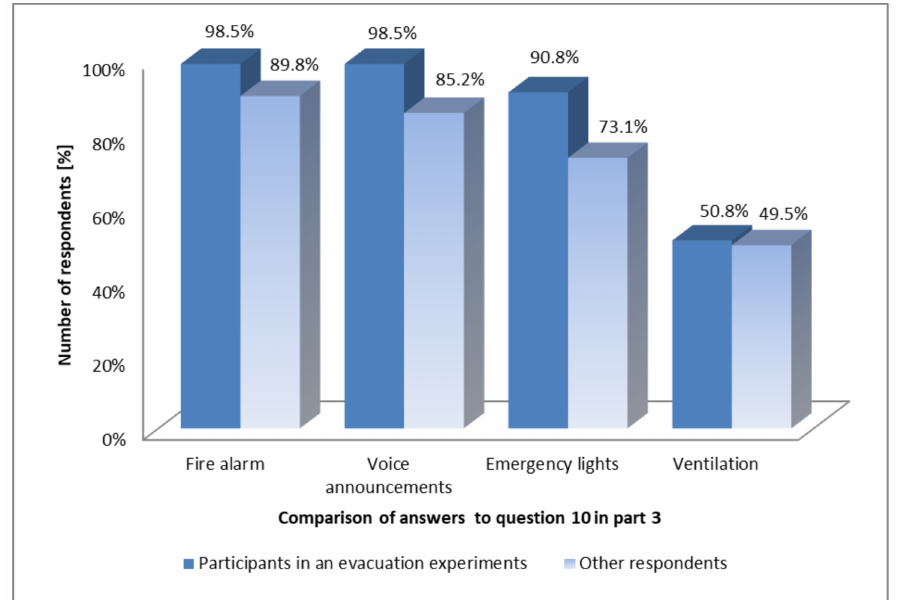
Figure 6. Answers given by the evacuation experiment’s participants and other respondents to the question about the systems which can be activated during a fire in a road